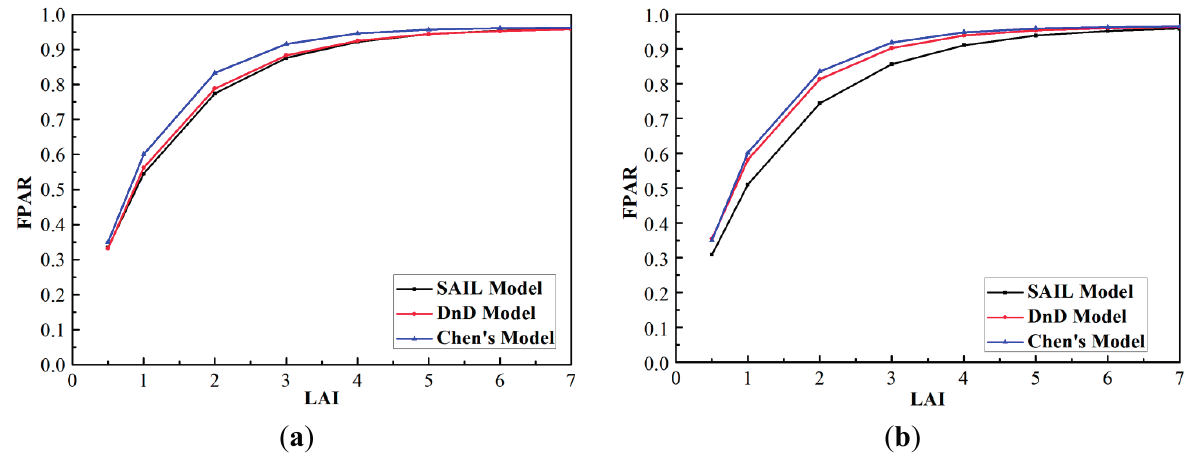
Figure 7. Differences among the three kinds of models based on simulated data: ( a ) with visibility of 5 km; ( b ) with visibility of 30 km. SAIL, scattering by arbitrarily-inclined leaves; DnD, direct and diffuse radiation.